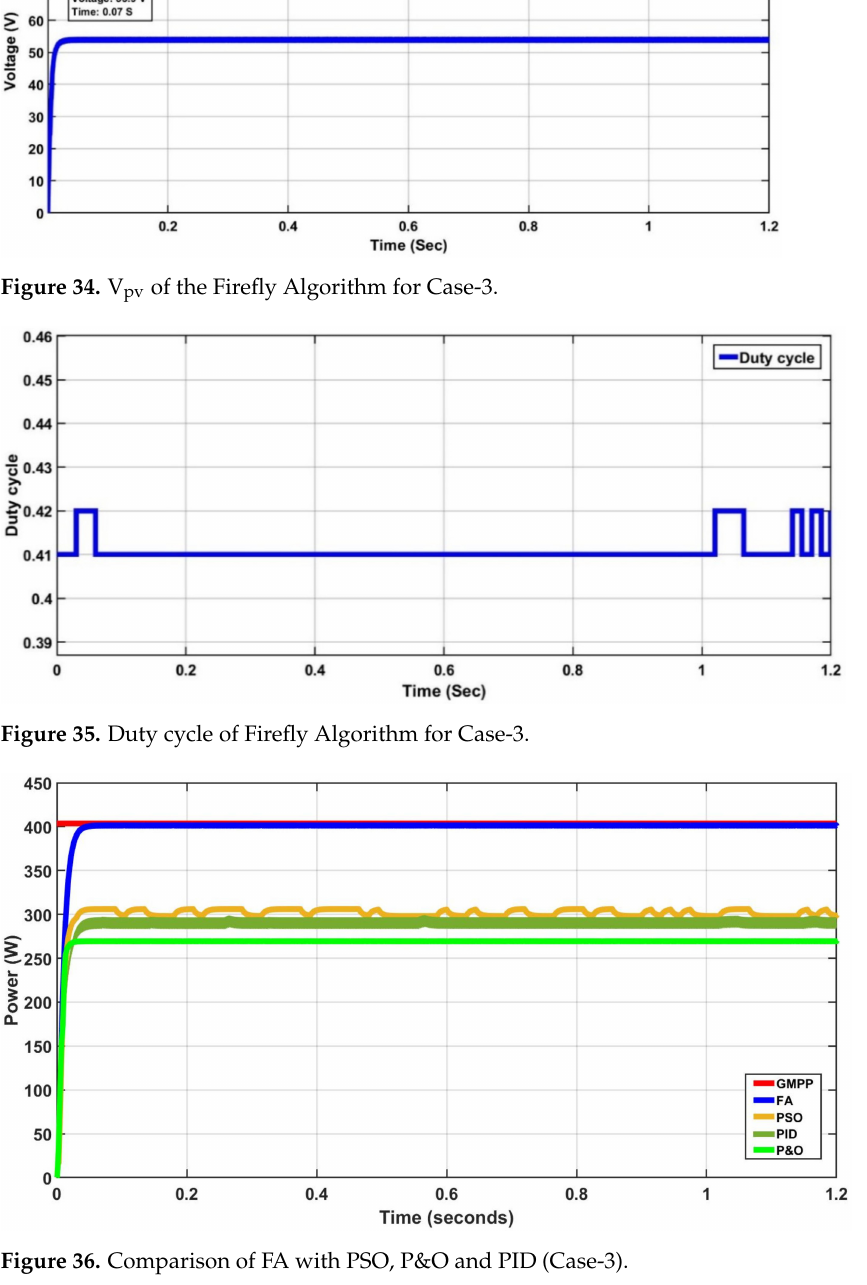
Figure 36. Comparison of FA with PSO, P&O and PID